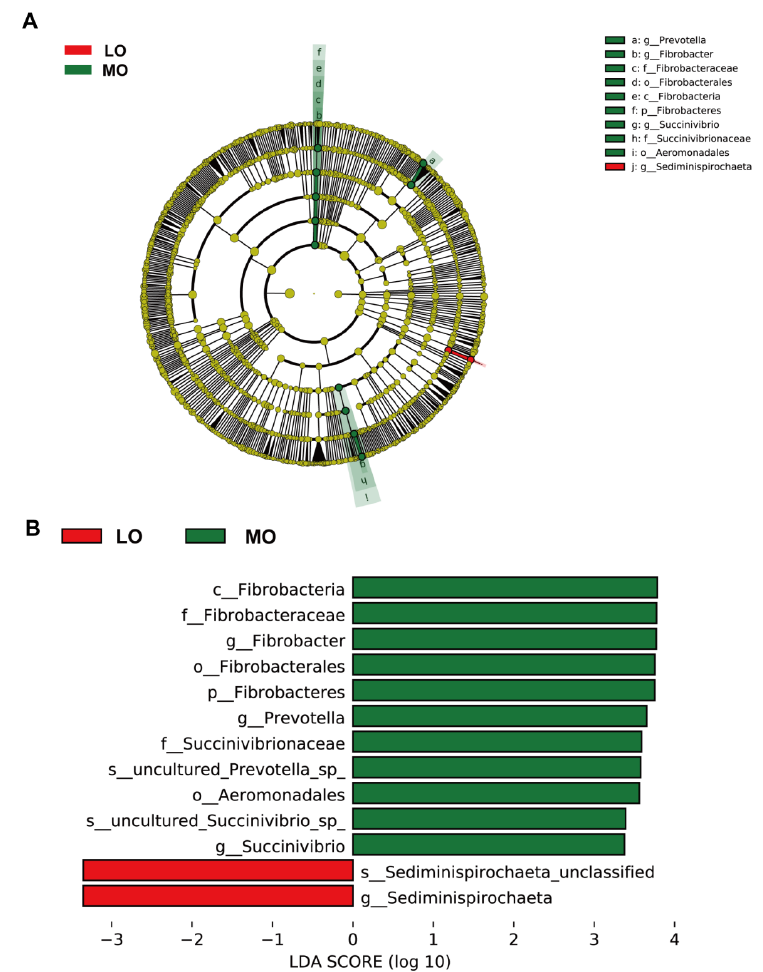
p Figure 3. Linear discrimination analysis (LDA) coupled with effect size (LEfSe) analysis of the rumen microbial community of lamb in the LO, MO, and HO groups ( n = 3). ( A ) Cladogram showing microbial species with significant differences among the two treatments. Red and green represent different groups. Species classification at the phylum, class, order, family, and genus level are displayed from inner to outer layers. The red and green nodes represent microbial species in the phylogenetic tree that play important roles in the MO and LO groups, respectively. Yellow nodes represent no significant difference between species. ( B ) Significantly different species with an LDA score greater than the estimated value (default score = 3). The length of the histogram represents the LDA score of different species in the LO, MO, and HO groups. LO, low oat percentages group; MO, medium oat percentages group; HO, high oat percentages